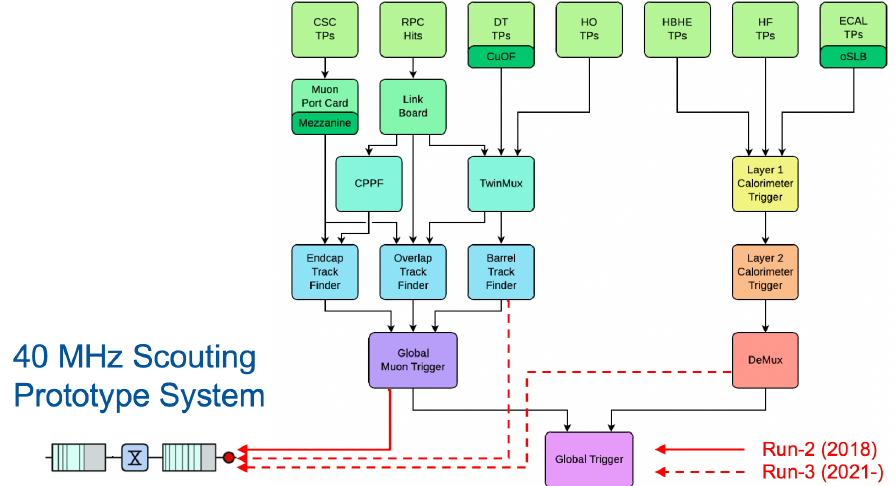
Fig. 4. The Phase-1 Level-1 trigger of CMS and connection of scouting system